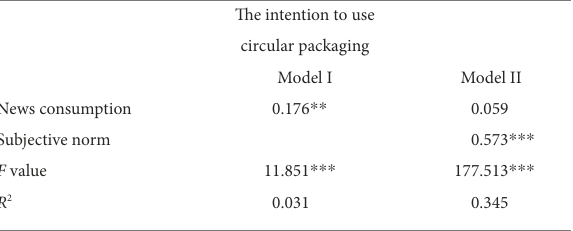
TABLE 5 Analysis of news consumption and the perceived behavioral control toward the use of circular